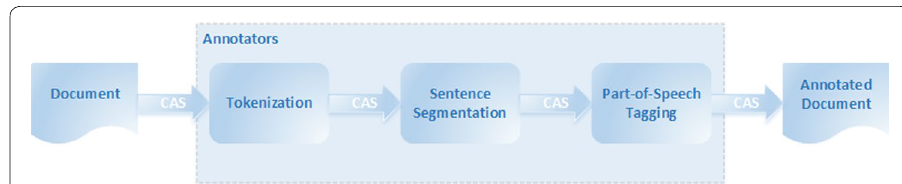
Fig. 1 Common UIMA pipeline for annotating